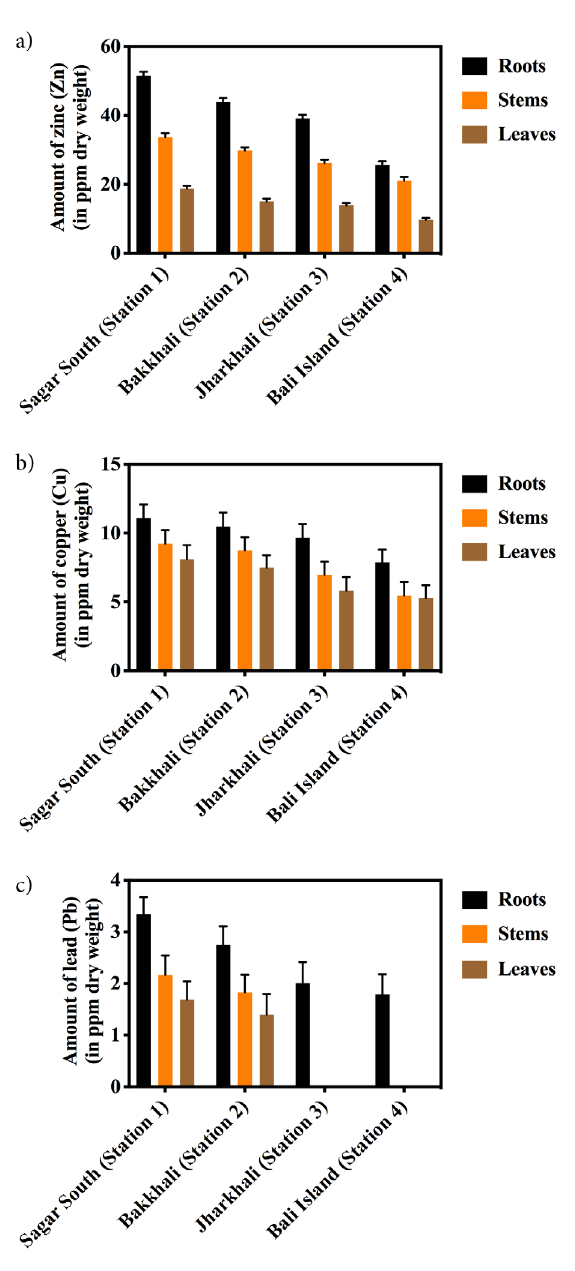
Figure 6. Heavy metal bioaccumulation within the vegetative tissues of Salicornia brachiata sampled from the selected study sites in the Hooghly-Matla estuarine complex of Indian Sundarbans. Error bars indicate standard deviation from the mean of triplicate